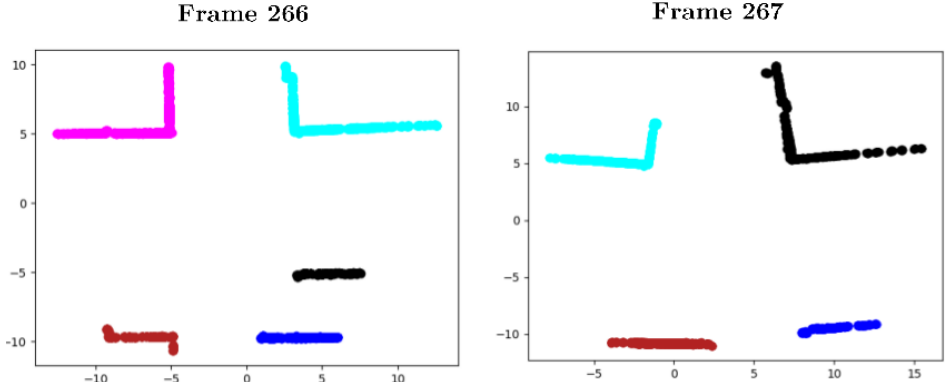
Figure 14. Odometry results with Singular Value Decomposition (SVD): Input cluster to extract synthetic